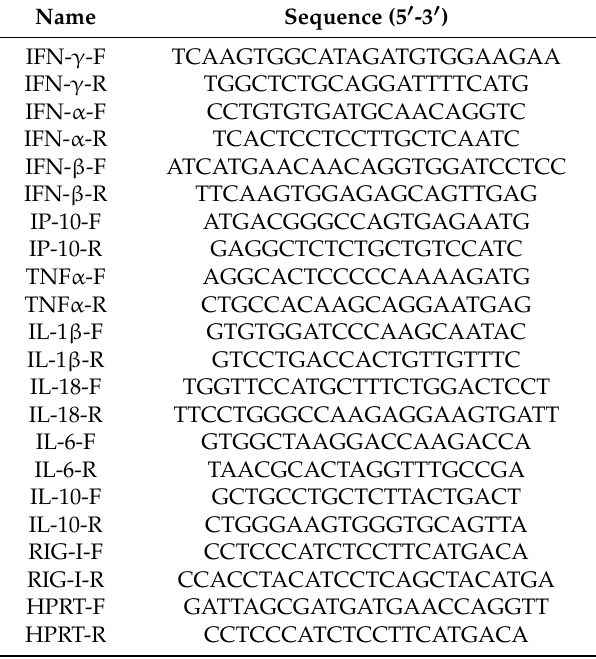
Table 1. List of primers used in RT-qPCR studies in mice. All primers have been validated to have greater than 95% of amplification efficiency. The expression levels of cytokine mRNA were normalized to the expression of the housekeeping gene HPRT. F: forward primer; R: reverse